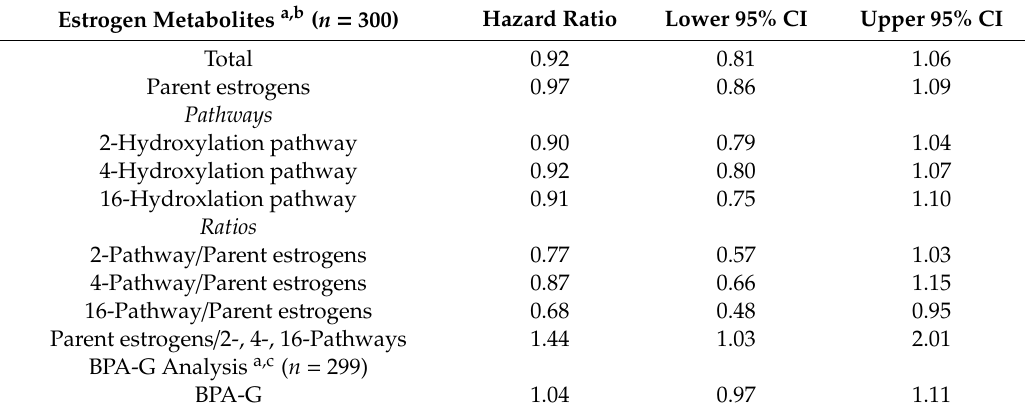
Table 3. Hazard Ratio (HR) and 95% confidence interval for onset of thelarche by estrogens and BPA among British and Bangladeshi girls 5–16 years of age, ABBY Project.